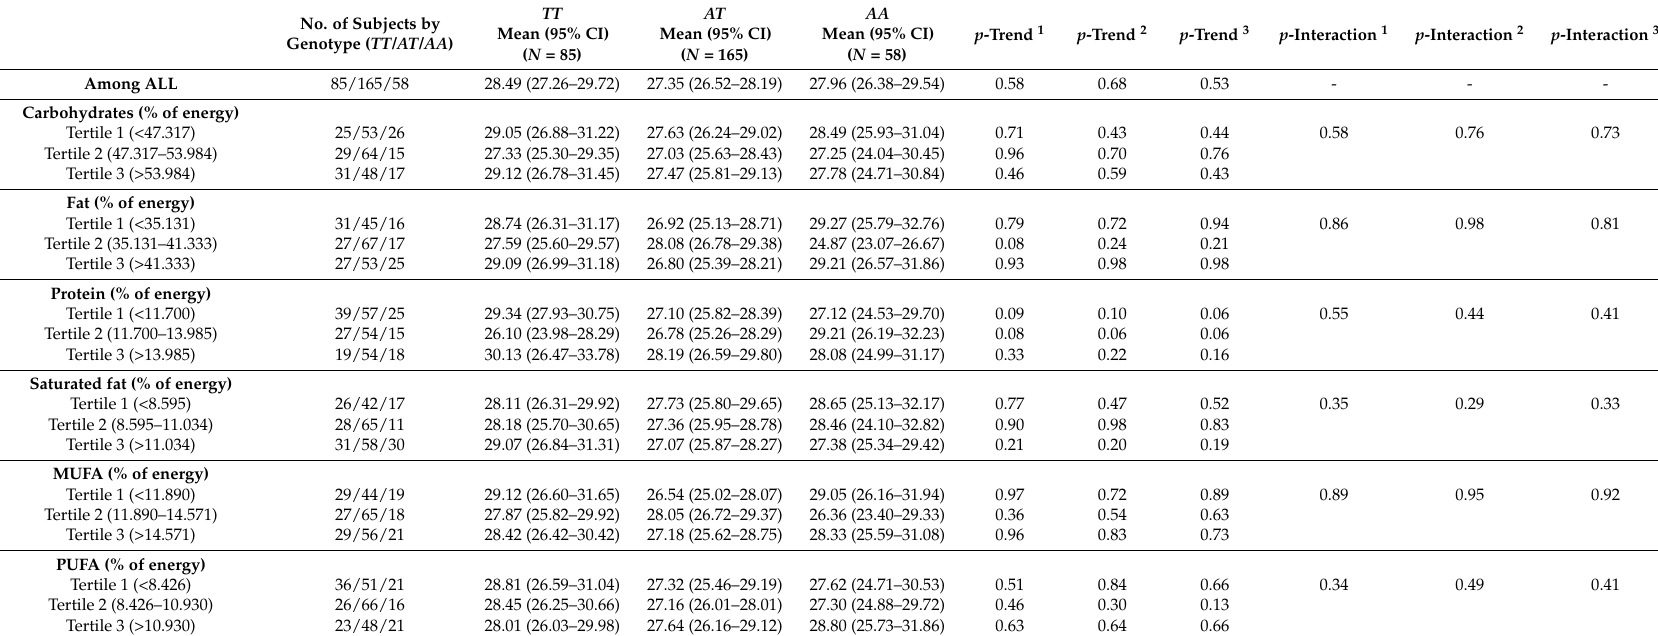
Table 2. Interaction between daily dietary intake and FTO ( rs1558902 ) genotypes with BMI (kg/m 2